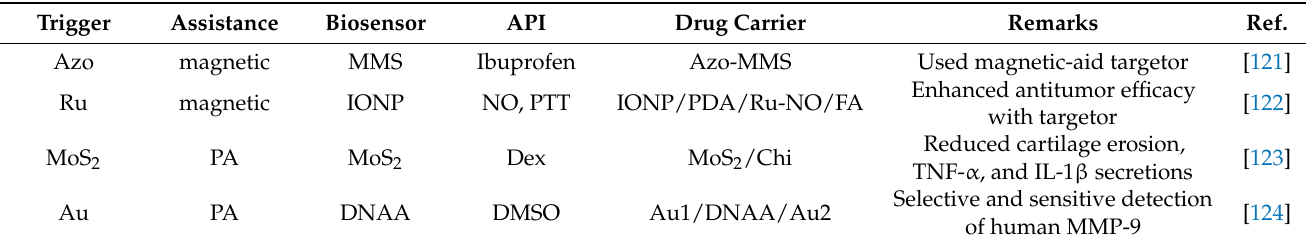
Table 3. Photothermal triggers with the assistance of magnetic-aid targetors or PA detections in drug carriers with biosensors, with remarks listed.